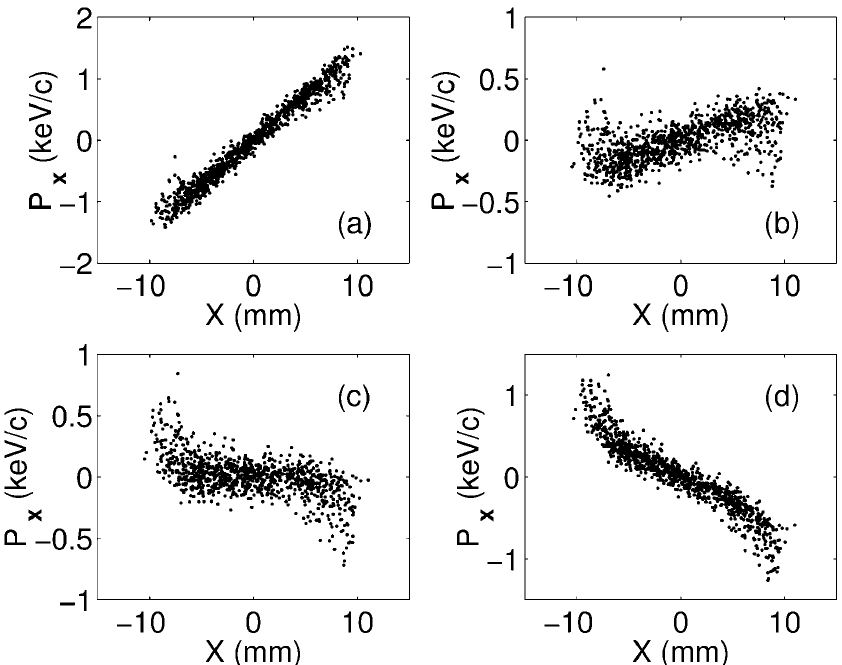
FIG. 7. Scatter plot of the phase space projection p x versus x from the experimental transport line simulation at (a) s (cid:1) 85 , (b) 116, (c) 124, and (d) 136 cm. At 136 cm, electrons at large j x j have higher transverse momenta and a greater slope j dp x (cid:1) dx j than the inner core electrons.